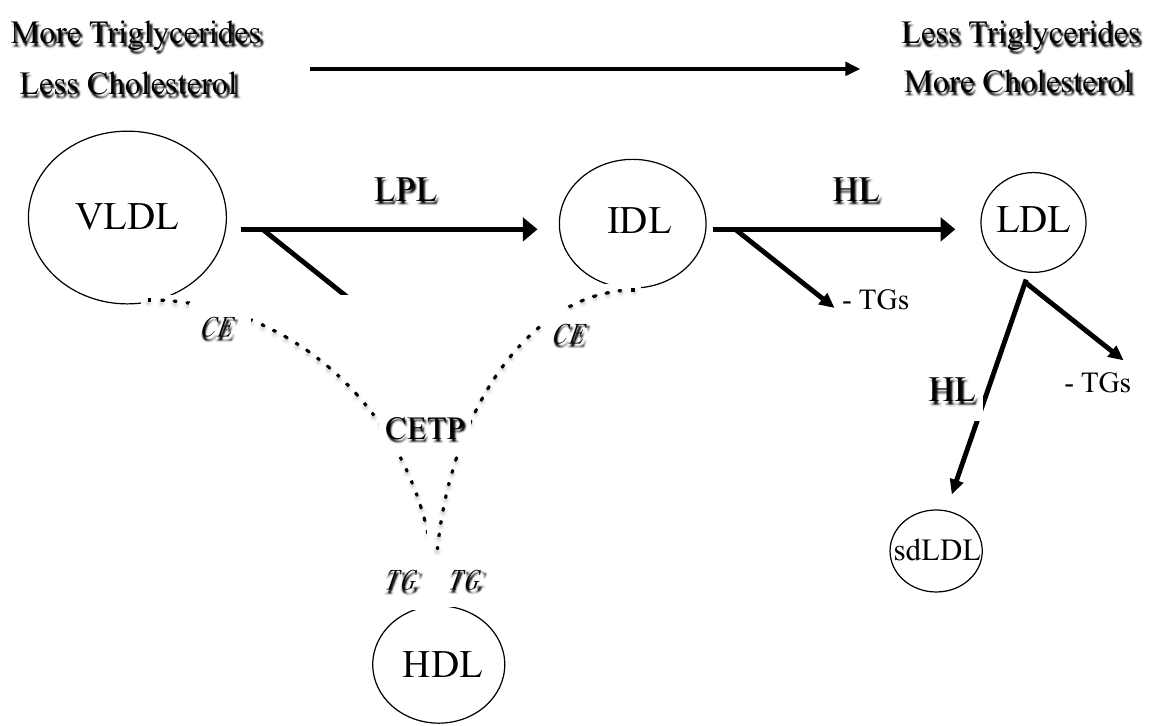
Figure 1. The formation of small dense LDL. Legend: VLDL: very low density lipoproteins; IDL: intermediate density lipoproteins; LDL: low density lipoproteins; HDL: high-density lipoproteins; TG: triglycerides; CE: cholesterol esters; LPL: lipoprotein lipase; HL: hepatic lipase; CETP: cholesterol-ester transfer protein.